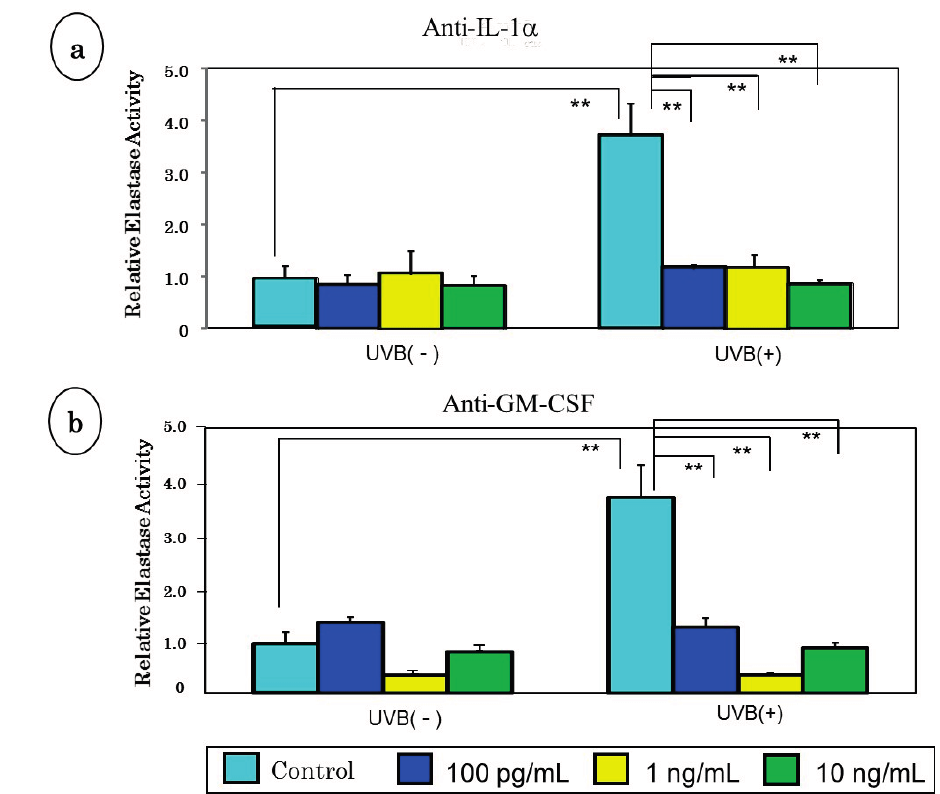
Figure 6. A neutralizing antibody abrogates the stimulated neprilysin activity. ( A ) HaCaT cells, ( a ) anti-human IL-1 α antibody; ( b ) anti-human GM-CSF antibody; ( c ) anti-human IL-6 antibody; ( d ) anti-human IL-8 antibody; ( e ) anti-human TNF α antibody; ( f ) non-specific mouse IgG; ( B ) human primary keratinocytes, ( a ) anti-human IL-1 α antibody; ( b )